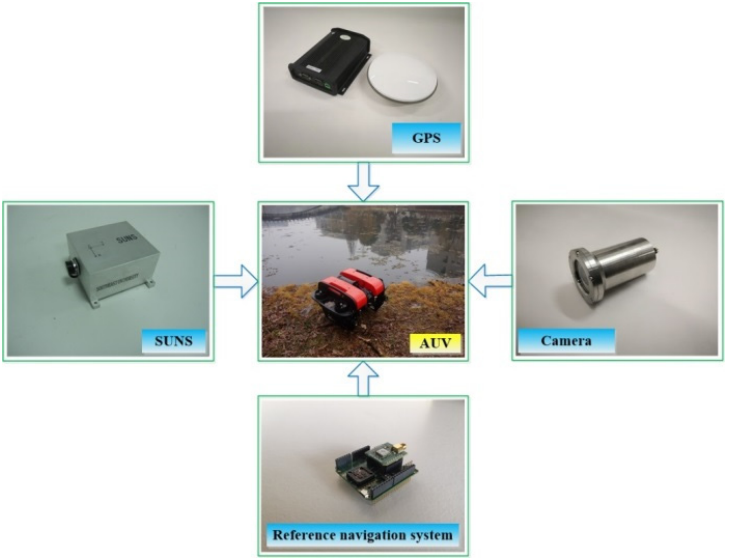
Figure 6. The platform of underwater positioning trial. Table 2. The specifications for IMU.